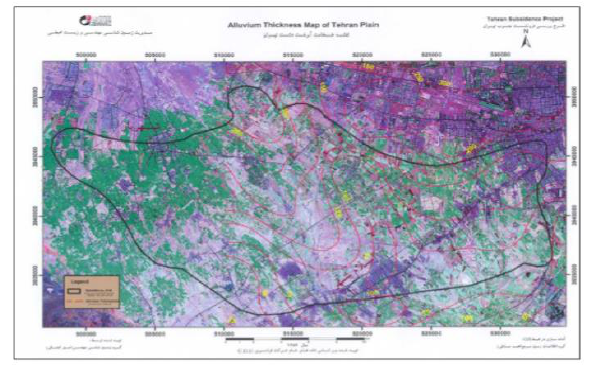
Figure 1. Alluvium thickness map of Tehran plain